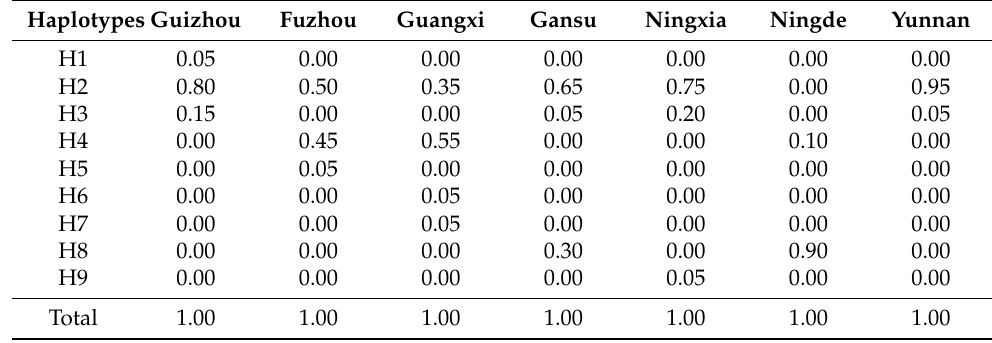
Table 4. Frequency and UV tolerance of deduced isoforms in the seven Phytophthora infestans populations sampled from